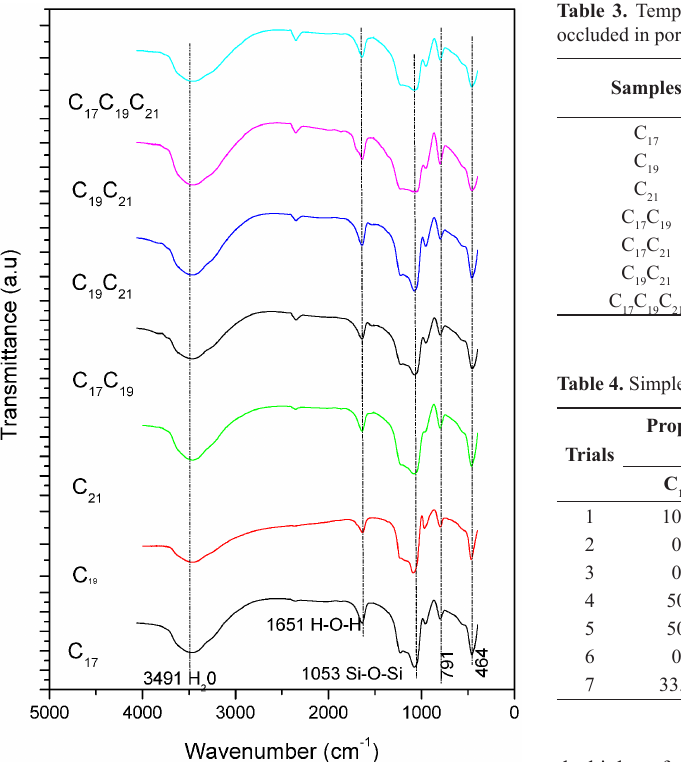
, C , C , C C , C C , 17 19 21 17 19 17 21